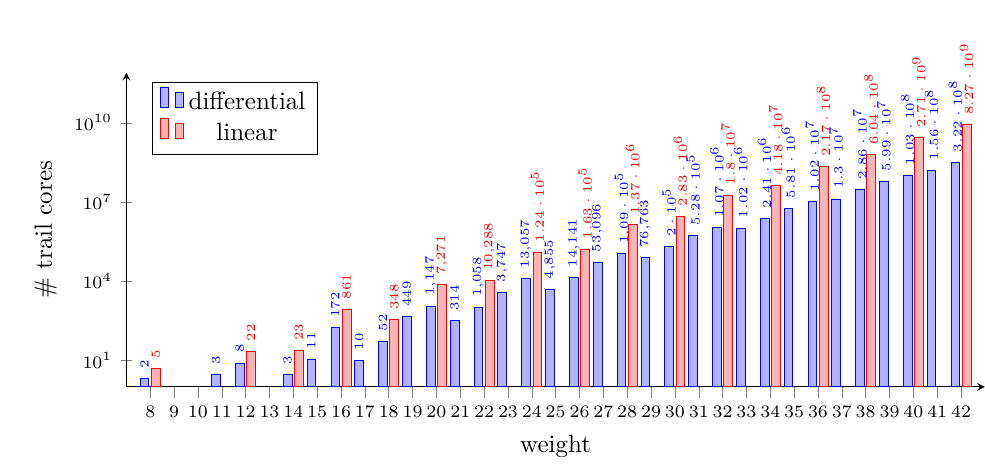
Figure 10: Number of all canonical 2-round trail cores per